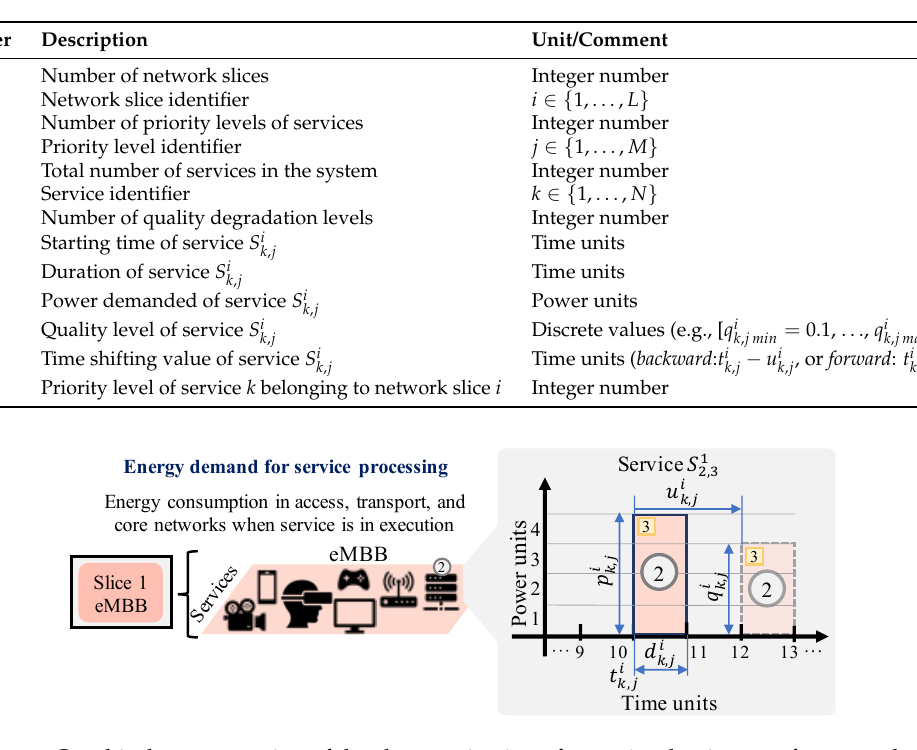
= 3, q 1 = 0.75 ( p 1 × q 1 = 3 ) 2 2,3 2,3 2,3